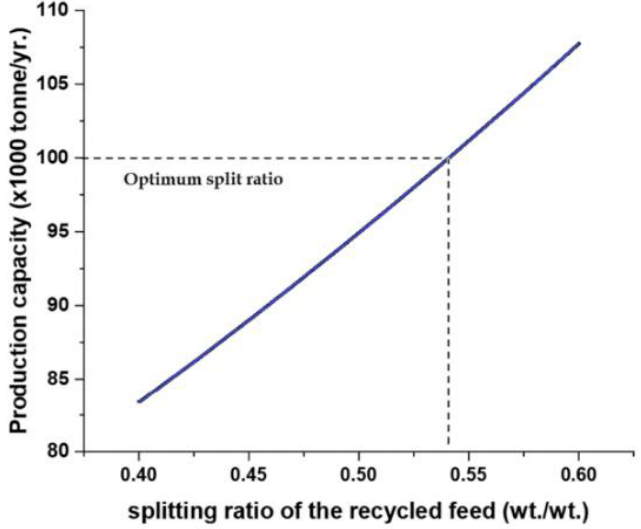
Figure 8. Effect of the purge splitting ratio on the methanol production capacity.